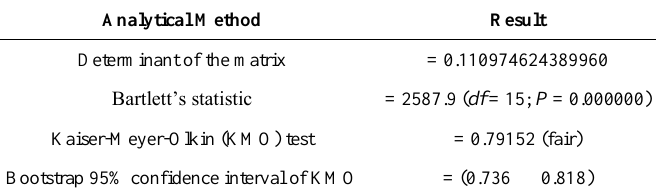
Table 4. Adequacy of the Tetrachoric Correlation Matrix